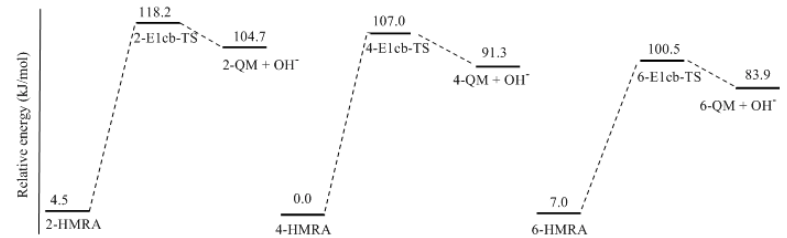
Figure 5. The potential energy profiles for E1cb formations of quinonemethides (QM).